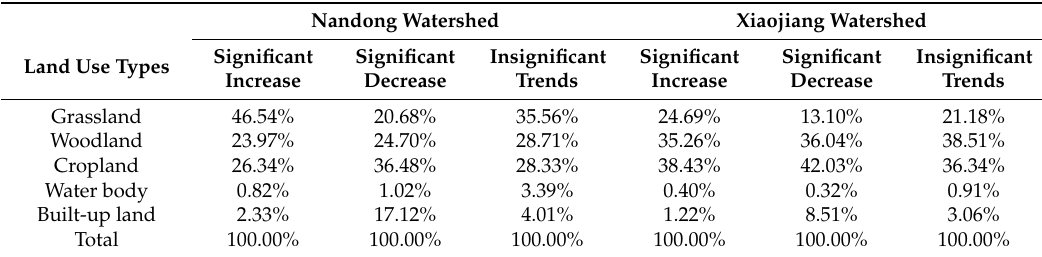
Figure 7. The spatial distribution of vegetation trends for different periods in the Xiaojiang watershed: ( a ) Full time series (1988–2016); ( b ) reference period (1988–2000); ( c ) conservation period (2001–2016); and ( d ) vegetation trend slope difference between the conservation period (2001–2016) and reference period (1988–2000). Table 1. Percentages of different land types versus three vegetation change trends.